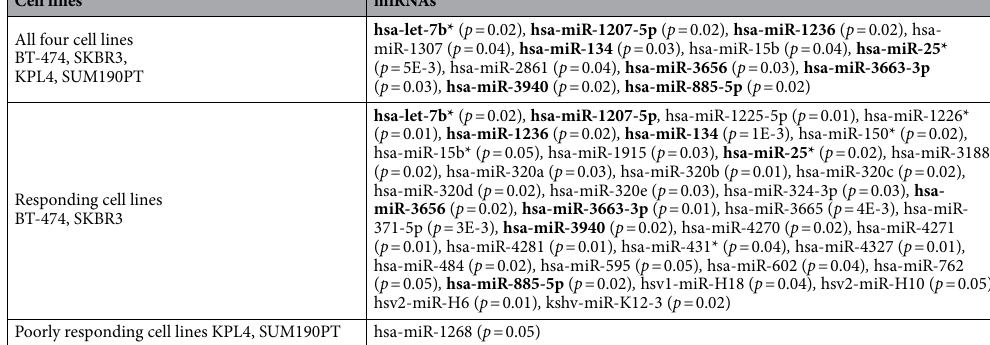
Table 1. miRNAs responding to HER2-targeted treatment (miRNAs are ordered alphabetically). p -values calculated using a Kruskal–Wallis test. Repeating miRNAs are highlighted in bold